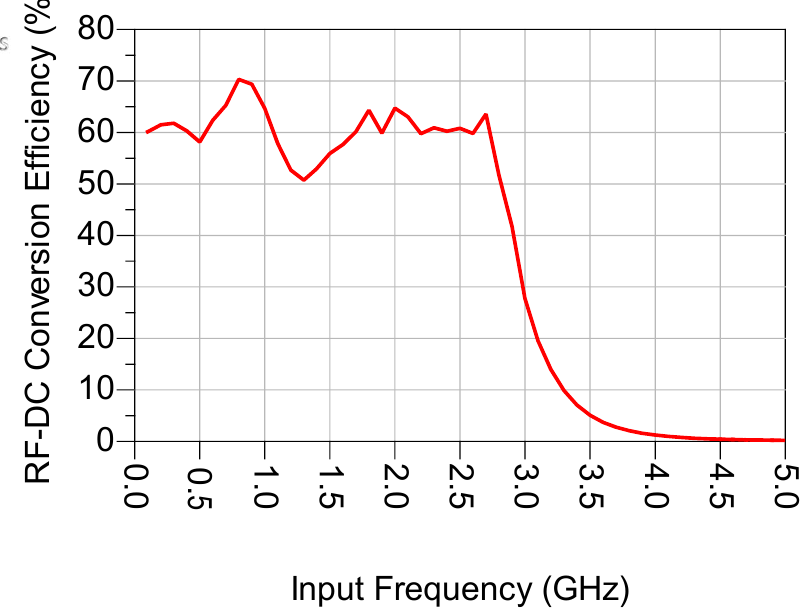
Figure 20. RF-DC conversion efficiency vs. the input frequency of the improved quad-band circuit with four receiving antennas based on Millman’s theorem for the load of 5 k Ω